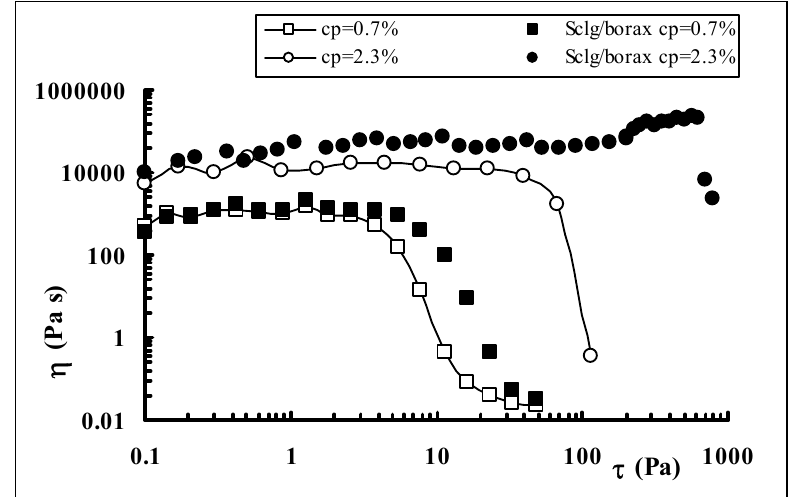
Figure 12. Flow curves at 25 °C for Sclg and Sclg/borax ( c p = 0 . 7 and